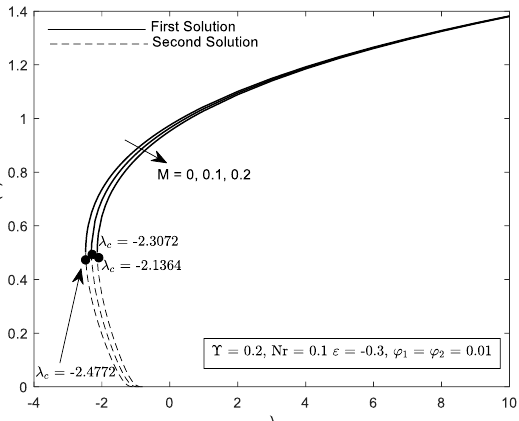
Figure 5. Variation of − θ (cid:48) ( 0 ) with mixed convection parameter, λ for several values of M . Figure 5. Variation of −𝜃 ′ (0) with mixed convection parameter, 𝜆 for several values of M . Figure 5. Variation of −𝜃 ′ (0) with mixed convection parameter, 𝜆 for several values of M . Figure 5. Variation of −𝜃 ′ (0) with mixed convection parameter, 𝜆 for several values of M .